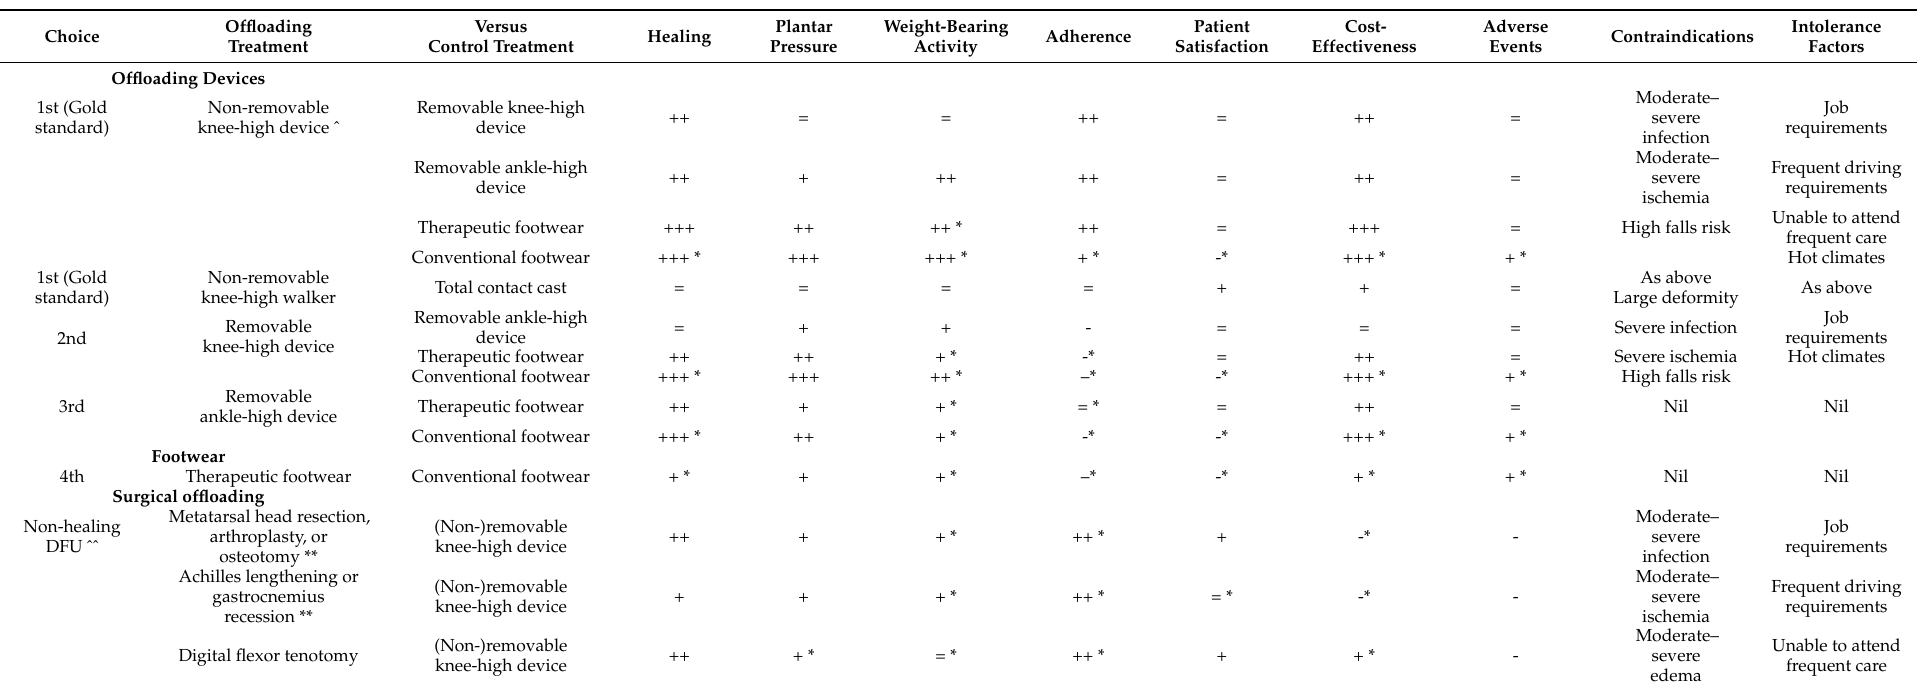
Table 1. Summary of the effects of offloading treatments on important outcomes, contraindications, and intolerance factors for people with diabetic foot ulcers (DFUs).